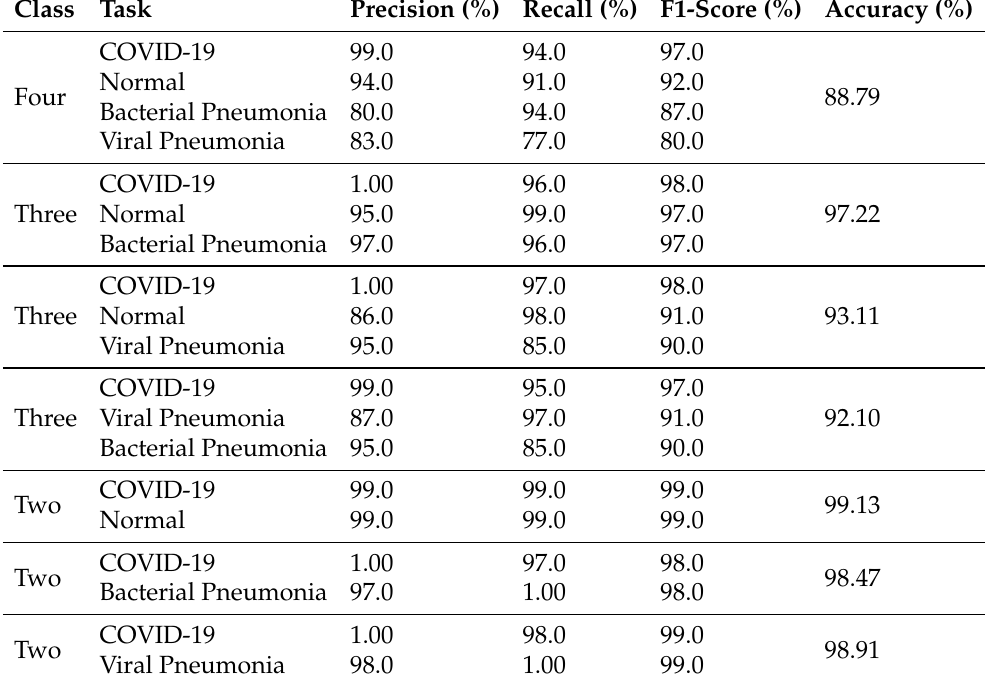
Table 6. Class-wise performance